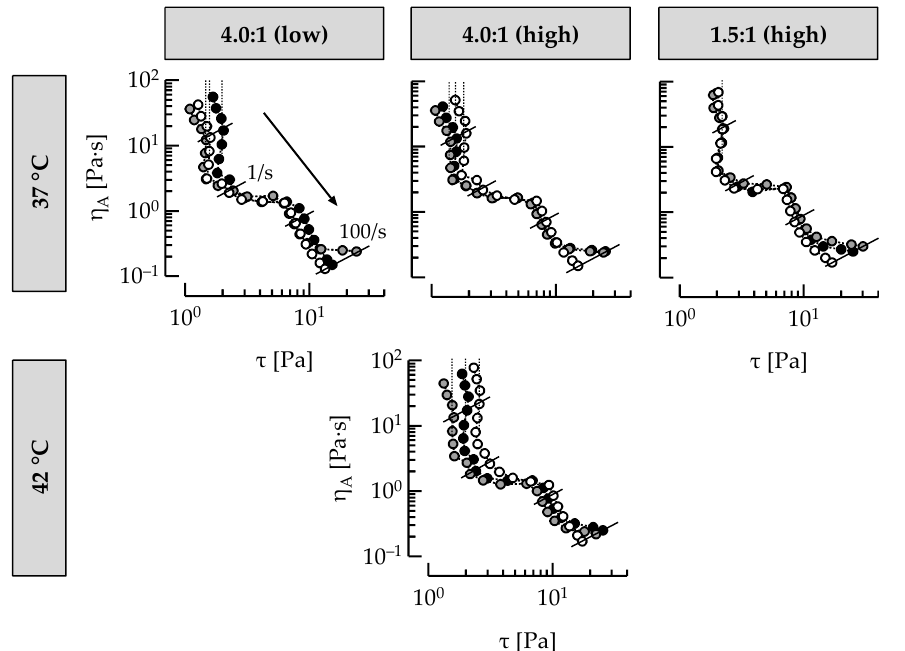
Figure 5. Apparent shear viscosity ( η A ) versus shear stress ( τ ) ( n = 6) of stirred gels produced with ST-1G+ (white), ST-2E+ (grey) or ST-2F (black) after 3 d of cold storage. The arrow indicates shear rate increase, dotted lines refer to static yield stress of the respective samples. Gels were produced from base milk with casein:whey protein ratio of 4.0:1 or 1.5:1 by inoculation with low- or high-activity starters, fermentation temperature was 37 °C or 42 °C.